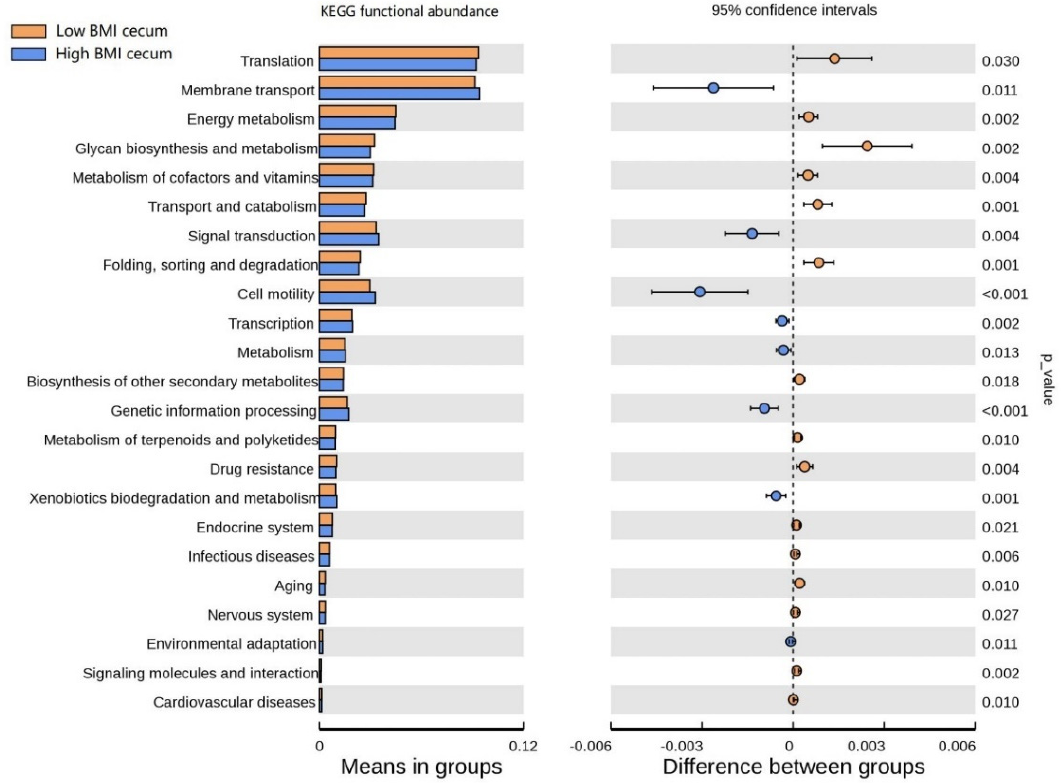
Figure 6. Differences of known functional pathways were compared. Tax4Fun used to evaluate functional contribution of cecal microorganisms.